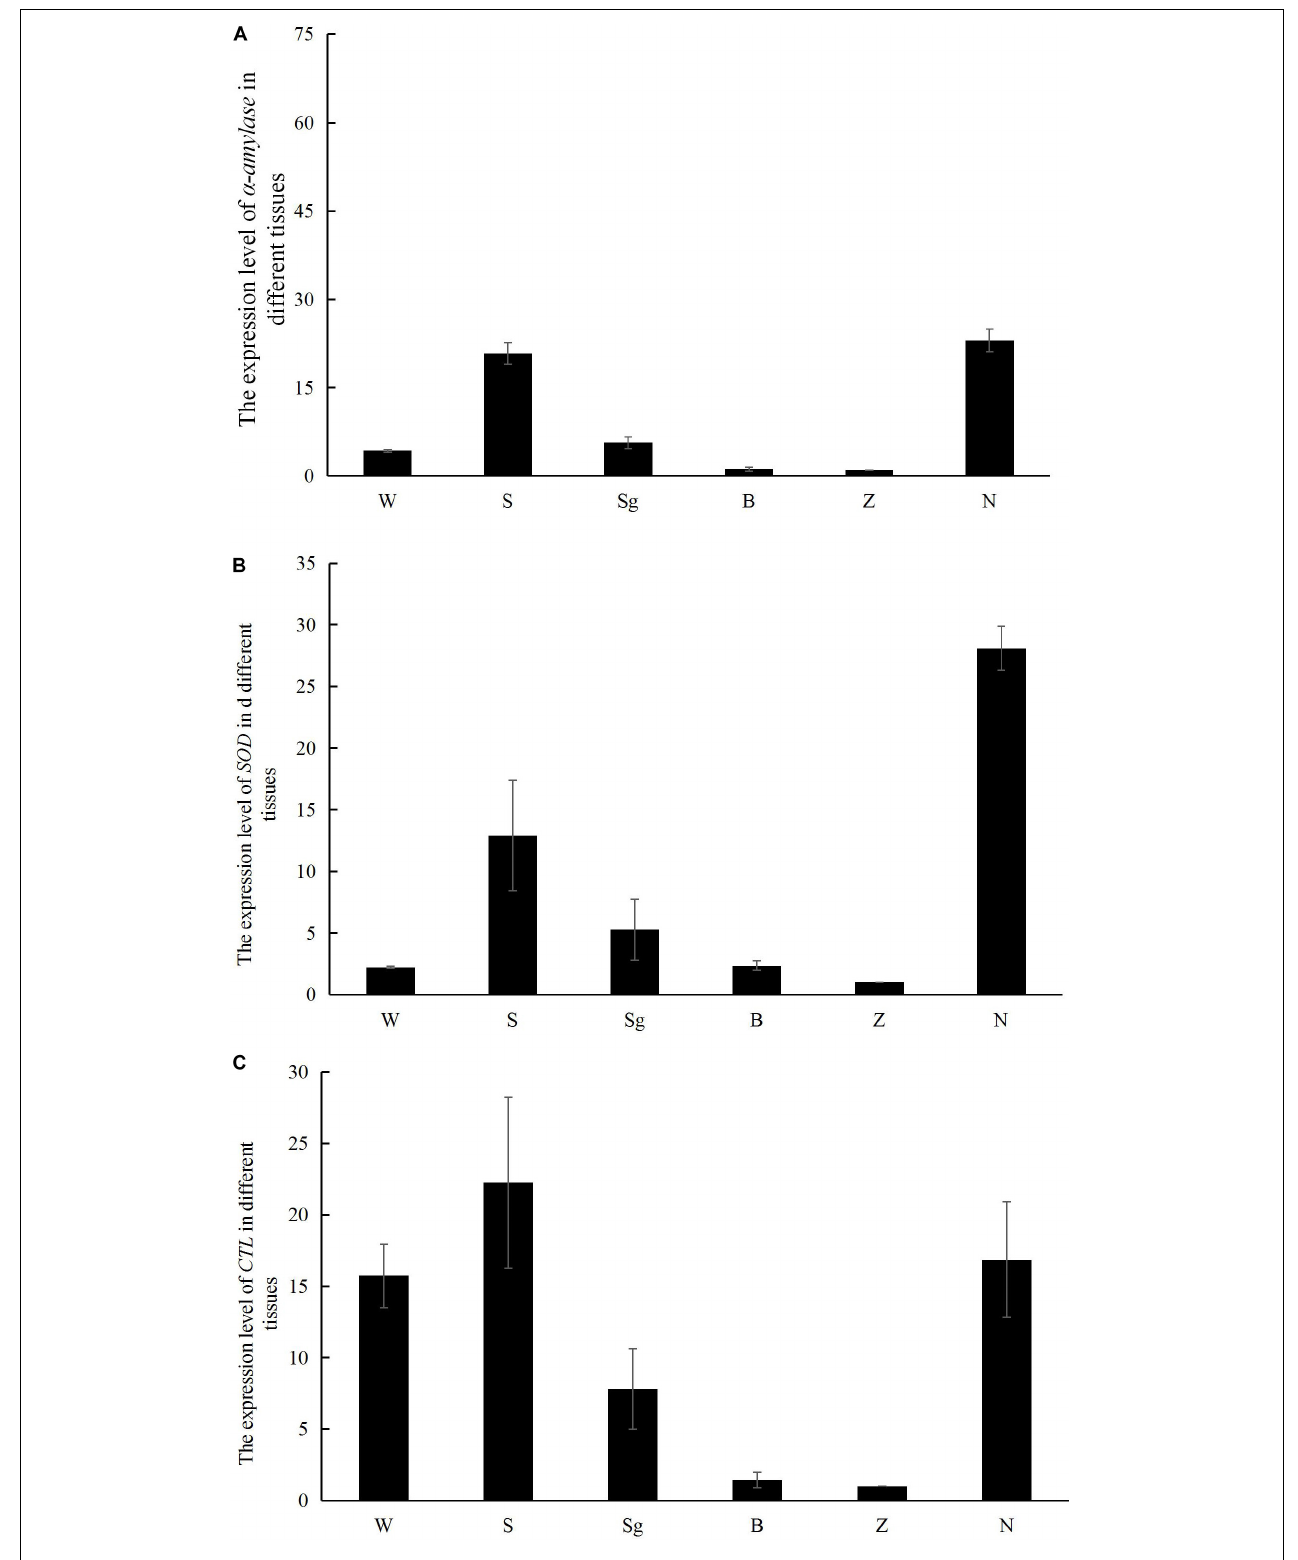
FIGURE 7 | The mRNA expression of α -amylase (A) , SOD (B) , and RpCTL (C) in different tissues of Manila clam, including mantle (W), gill (S), siphon (sg), adductor muscle (B), foot (Z), and hepatopancreas (N).